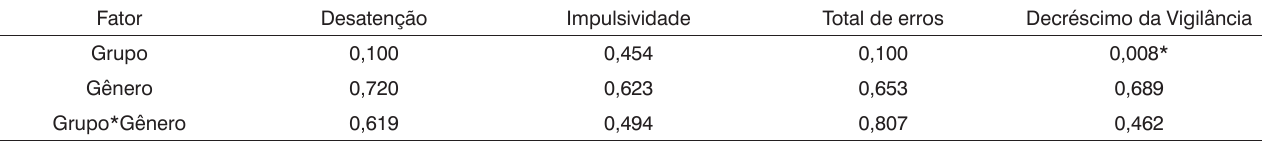
Tabela 3. Análise de variância com 2 fatores das variáveis do teste THAAS.